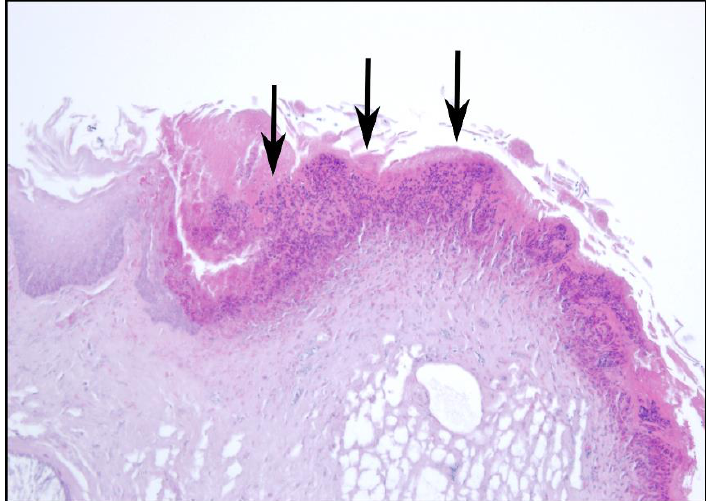
Figure 5. Ulcerative and purulent oesophagitis (black arrows), HE, 20×.